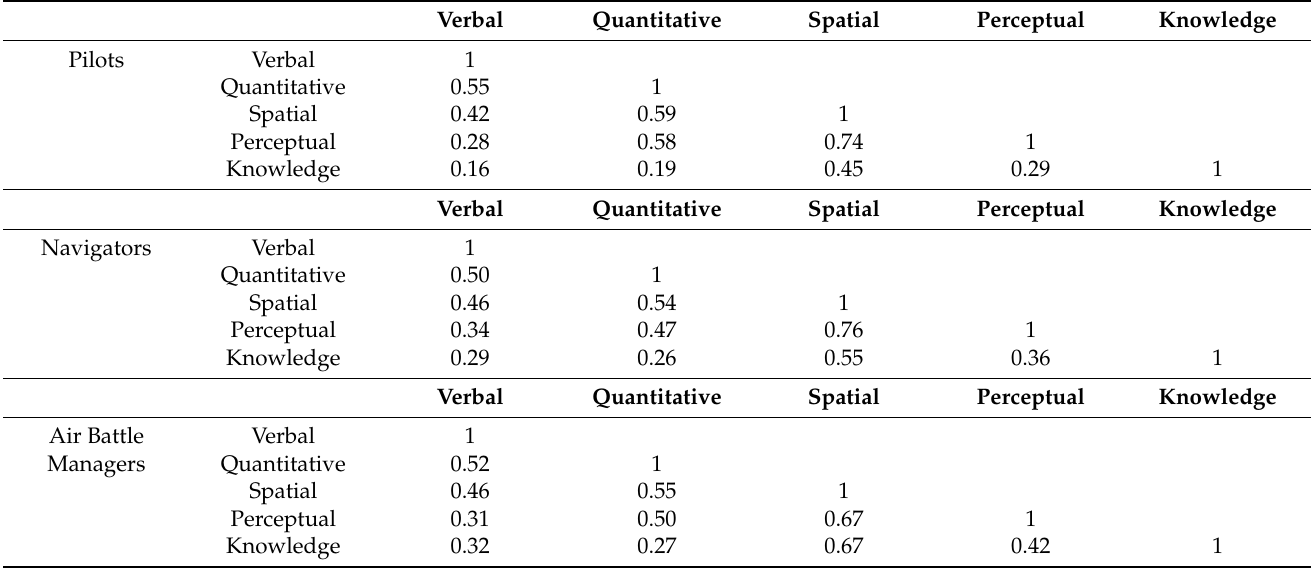
Table 3. Summary for the factor intercorrelations resulting from the CFA correlated-factor models. Verbal Quantitative Spatial